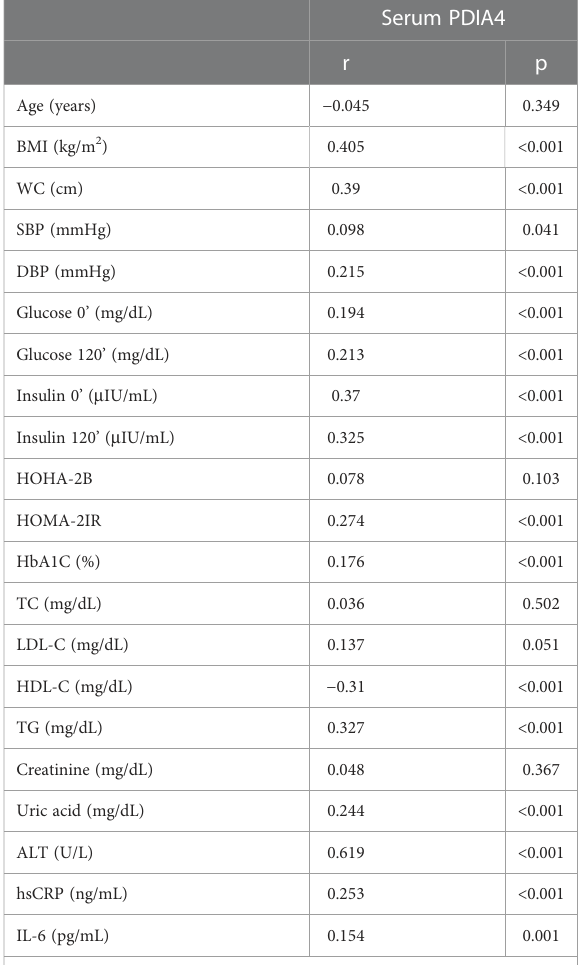
TABLE 3 Correlations between serum PDIA4 and clinical